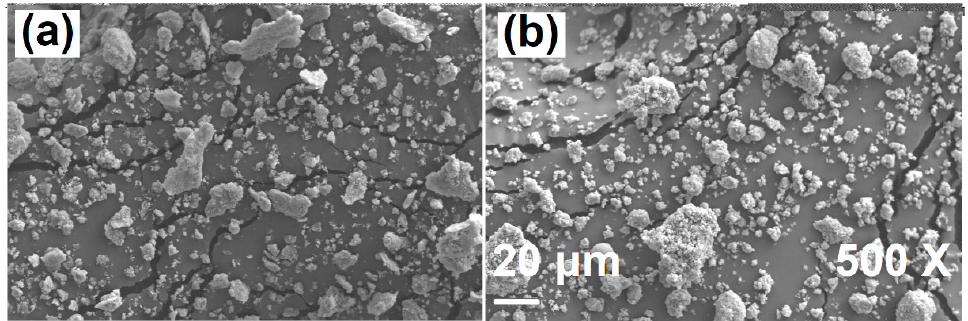
Figure 2. SEM micrographs of Mg65–Zn30–Ca5 milled for ( a ) 15 and ( b ) 20 h. Reprinted from Ref. [25]. Physics SRL, 2021.